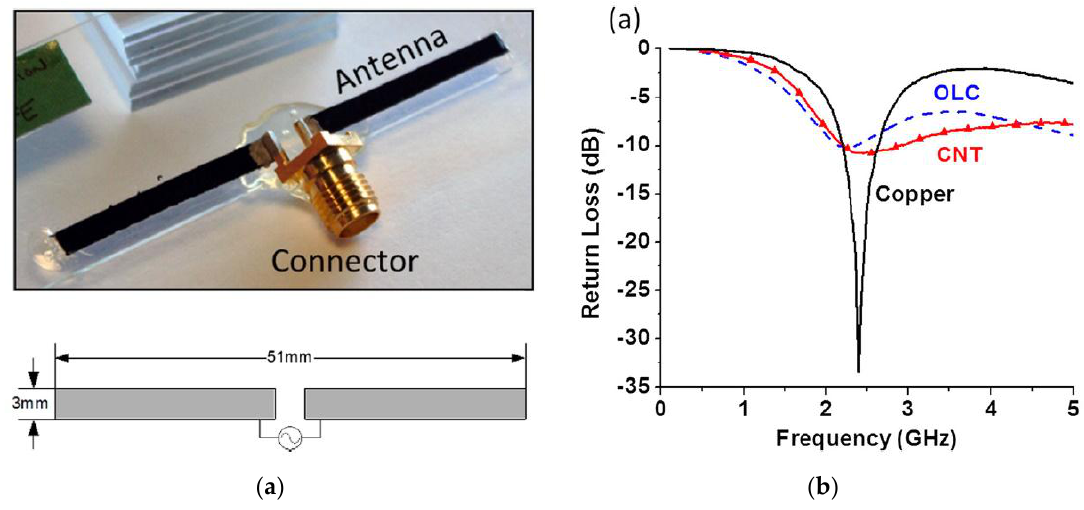
Figure 3. ( a ) Onion-like carbon (OLC) antenna; ( b ) return loss versus frequency of OLC, carbon nanotubes (CNT), and copper antennas [11]. (With permission from